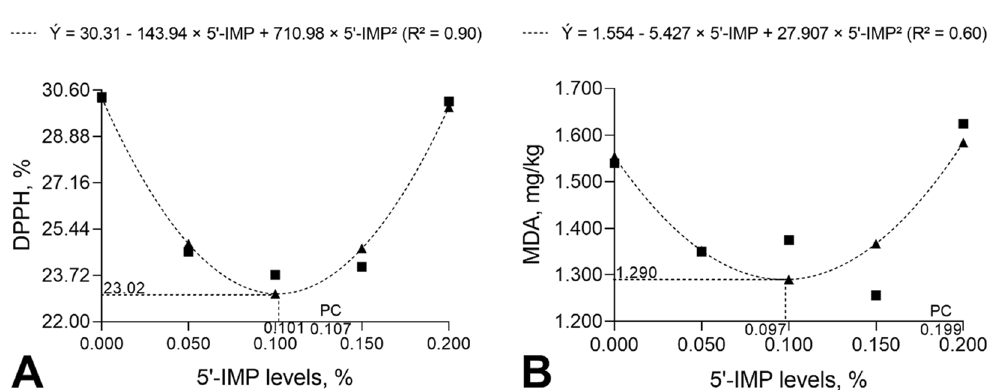
Figure 3. Free radical scavenging assay ( A ) and malondialdehyde (MDA) concentration ( B ) in the liver of 75–100 kg barrows fed diets containing different levels of inosine-5 ′ -monophosphate (5 ′ -IMP) and a 100 kcal/kg lower metabolizable energy level than the positive control (high-energy)